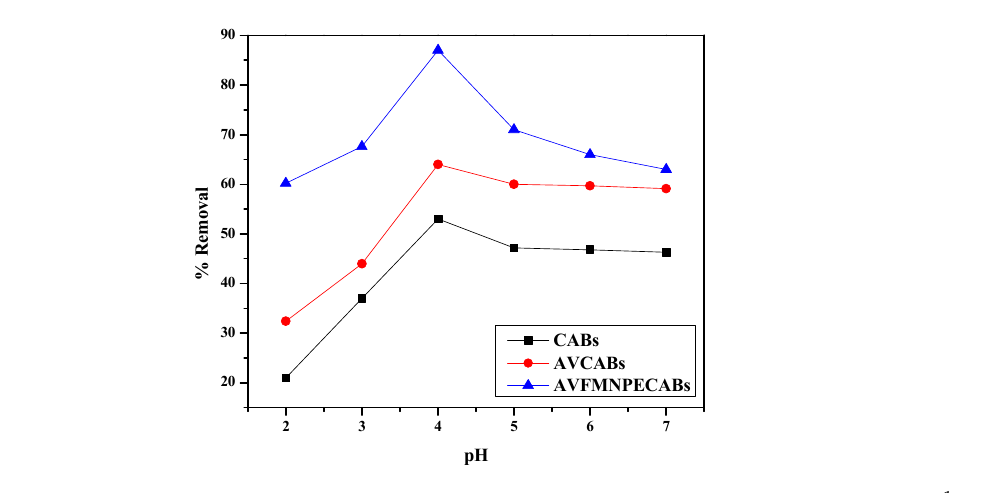
Figure 9. Point of zero charge (pH pzc ) of AVMNCABs, AVCABs, and CABs.